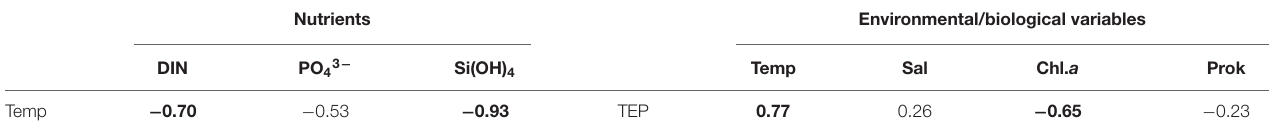
TABLE 3 | Spearman rank order correlations ( r ) between temperature and nutrients, transparent exopolymer particles, and environmental/biological variables a . Nutrients